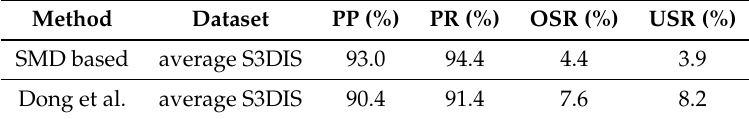
Table 4. Comparison of the proposed method (SMD) vs. Dong et al. [22].